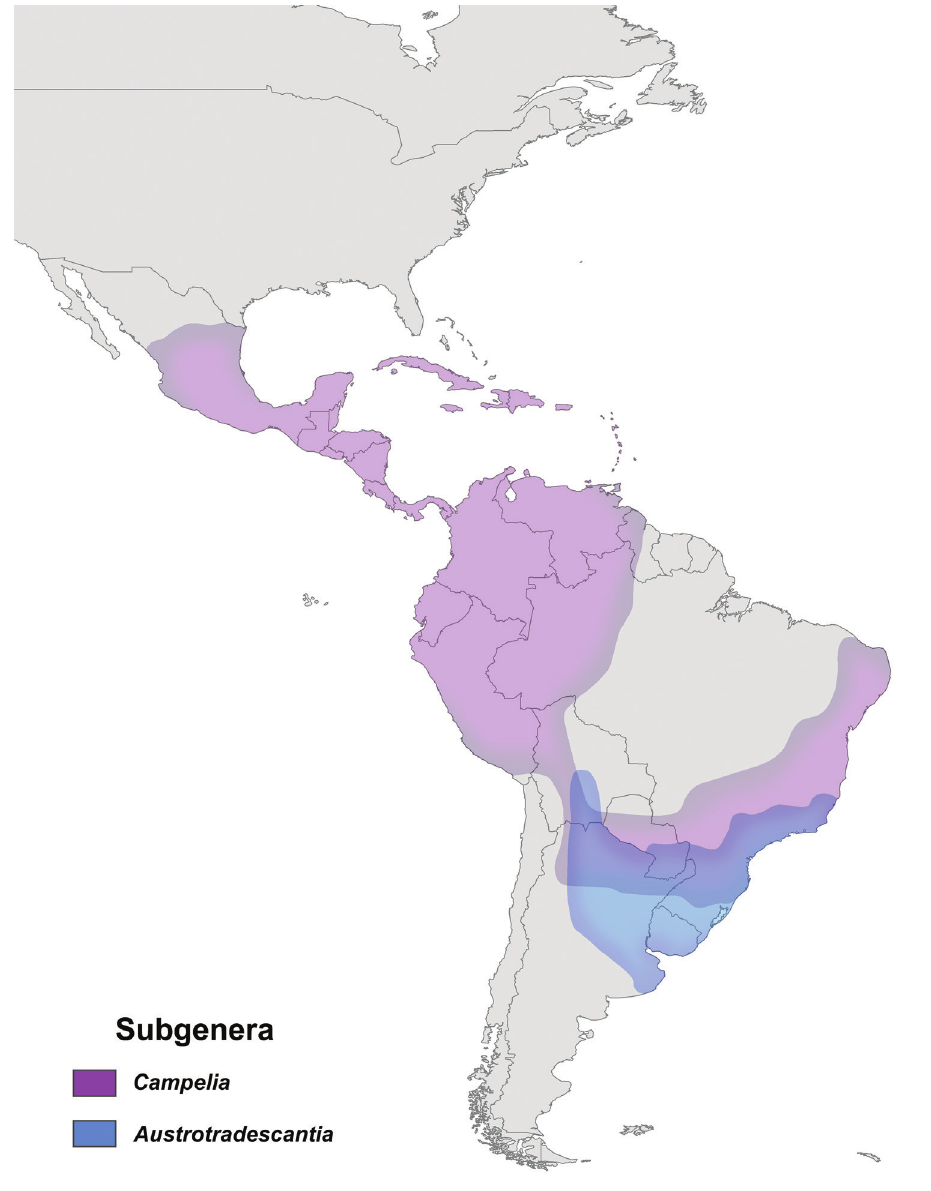
Figure 8. Distribution of Tradescantia subg. Austrotradescantia (D.R.Hunt) M.Pell. in blue, and of T. subg. Campelia (Rich.) M.Pell. in